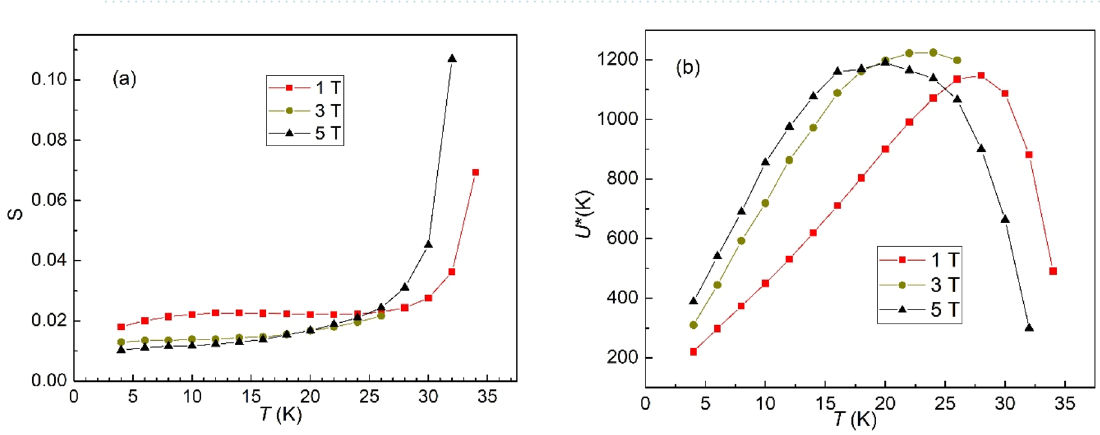
Figure 3. Temperature dependence of the normalized relaxation rate S = − dln(| m |)/dln( t ) ( a ); and of the normalized pinning potential U * = T / S ( b